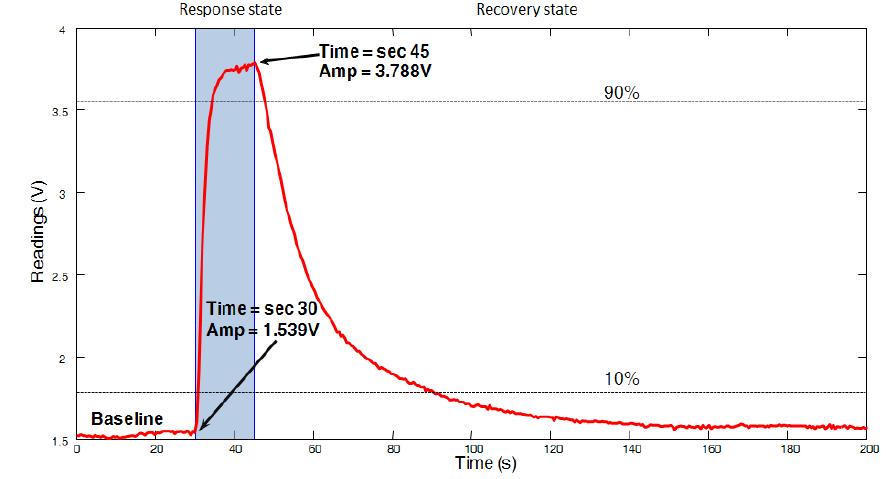
Figure 1. Response of a Figaro TGS 2620 MOS sensor when exposed to a gas source during 15 s (in blue). Observe how the signal response resembles that of two first-order systems: one for the rise phase and another, much slower one, for the decay phase. The excitation signal is unknown, but it is approximate by an ideal pulse of arbitrary